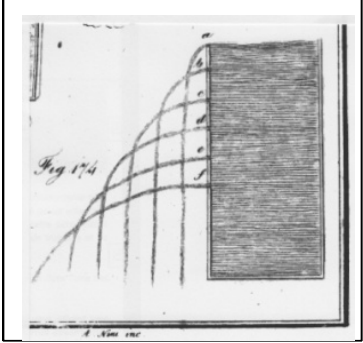
Fig. 1. Leonardo da Vinci suggested, as have many authors since, that for a pierced bottle, the closer the hole is to the bottom of the bottle, the greater the range of the emerging jet.